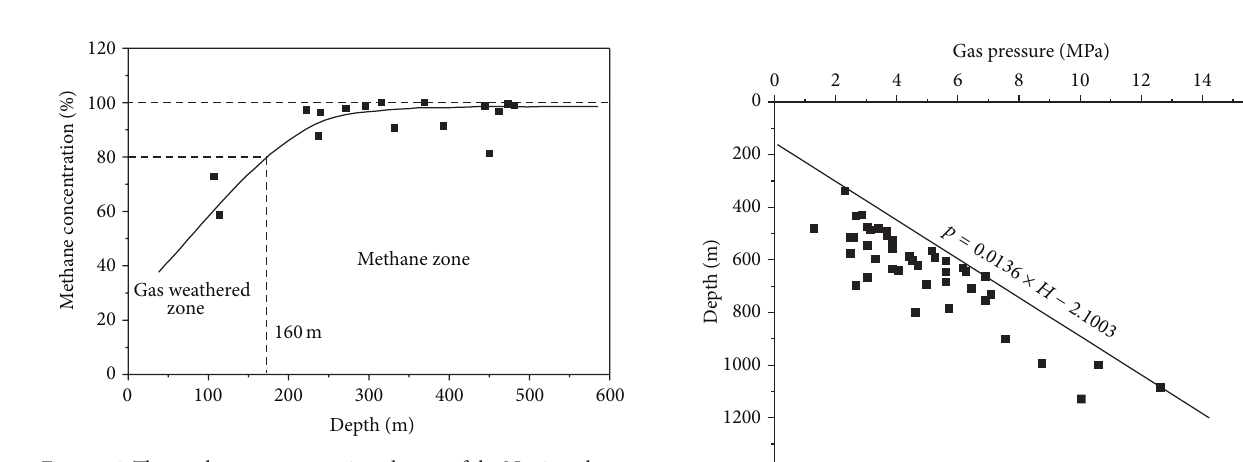
Figure 4: The methane concentration change of the No. 3 coal seam in the SQB with the depth.